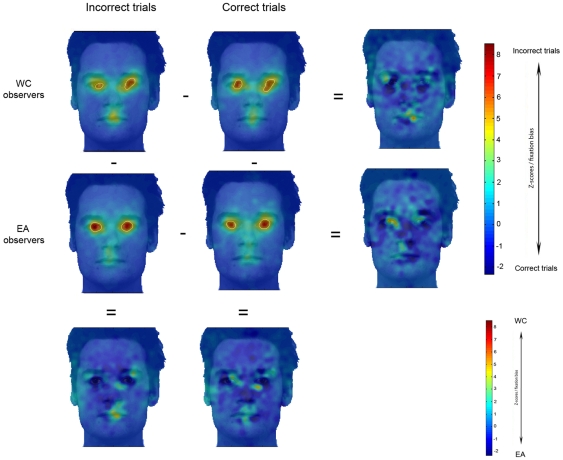
Fixation maps of Western Caucasian (WC) and East Asian (EA) observers for the 2° Spotlight condition during face recognition for incorrect and correct trials.Areas fixated above chance are delimited by white borders. Observers significantly fixated more on the eye region than the rest of the face regardless their accuracy (about 28 trials per condition); on those maps the darker blue represents 0. Right: Note the absence of significant differences in the fixation strategies as a function of correct and incorrect trials in both groups of observers. Bottom: differential fixation biases for Western Caucasian (WC - red) and East Asian (EA - blue) observers are highlighted by subtracting the WC and the EA Z-scored group fixation maps for incorrect and correct trials respectively. No significant cultural differences were found for this comparison.